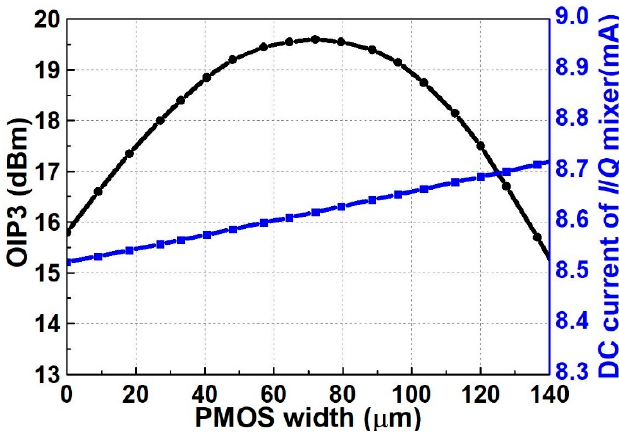
Figure 3. ( a ) Inverter-type transconductor (NMOS M n1 and PMOS M p1 ) and switching transistors M n2 and M n3 from up-conversion mixer, ( b ) 𝑔 (cid:3040)(cid:4593) and 𝑔 (cid:3040)(cid:4593)(cid:4593) of small signal output current i o of inverter-type transconductor over the width of PMOS M p1 with a channel length of 65 nm.